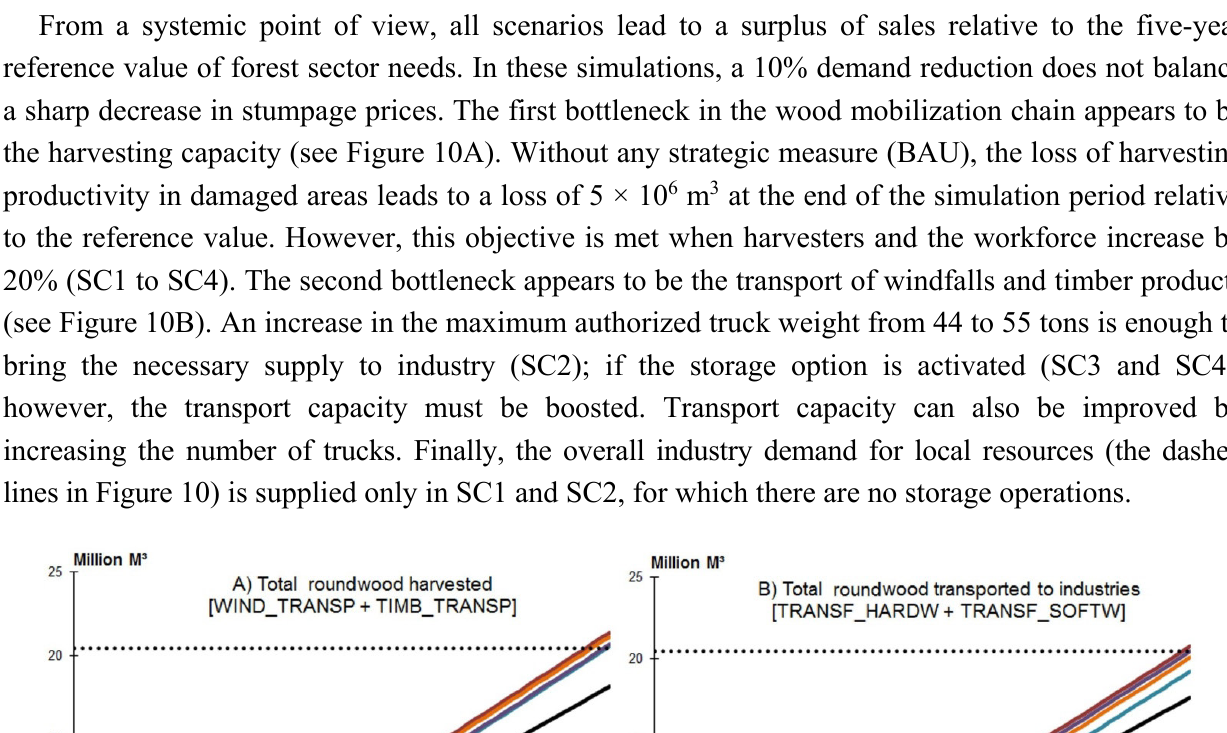
Figure 9. Levels of stocks (million m 3 ) for business-as-usual (BAU) and crisis scenarios (SC1 to SC4).